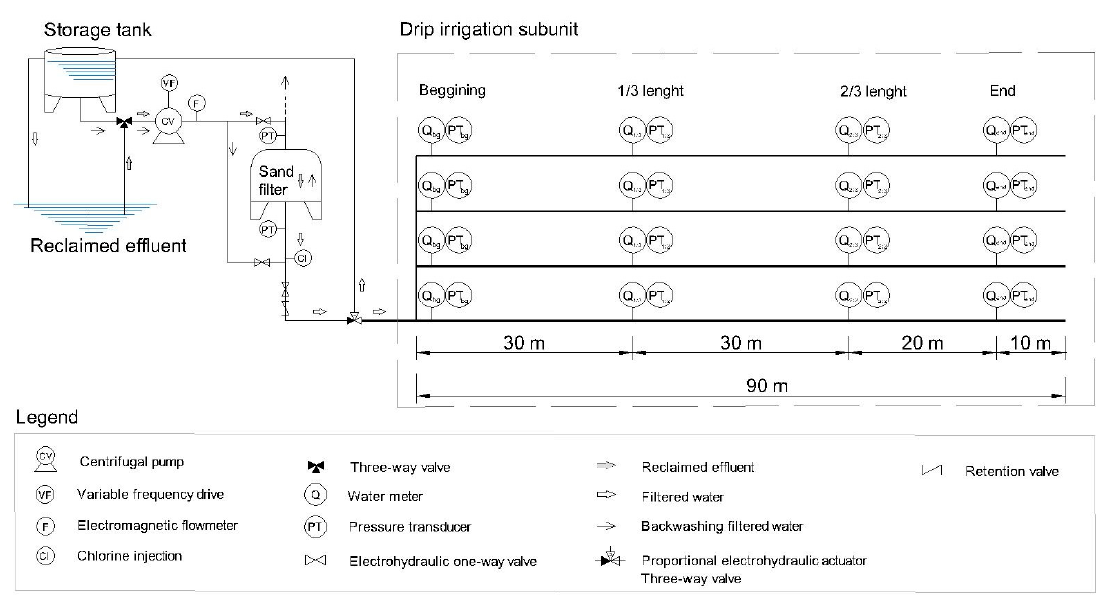
Figure 1. Diagram of the experimental irrigation system. For simplicity, only one out of the three drip irrigation subunits is depicted.